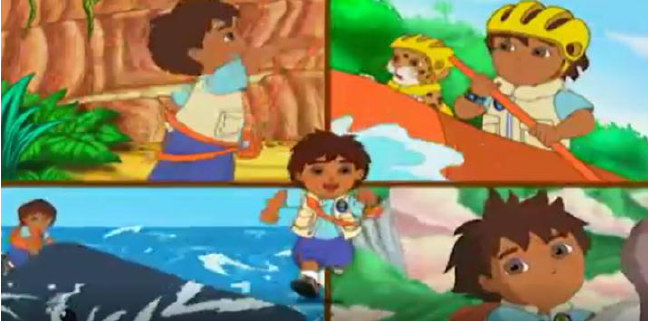
FIGURE 3 | Warm-Up Activity for Grade 4 – Diego’s Adventure Video